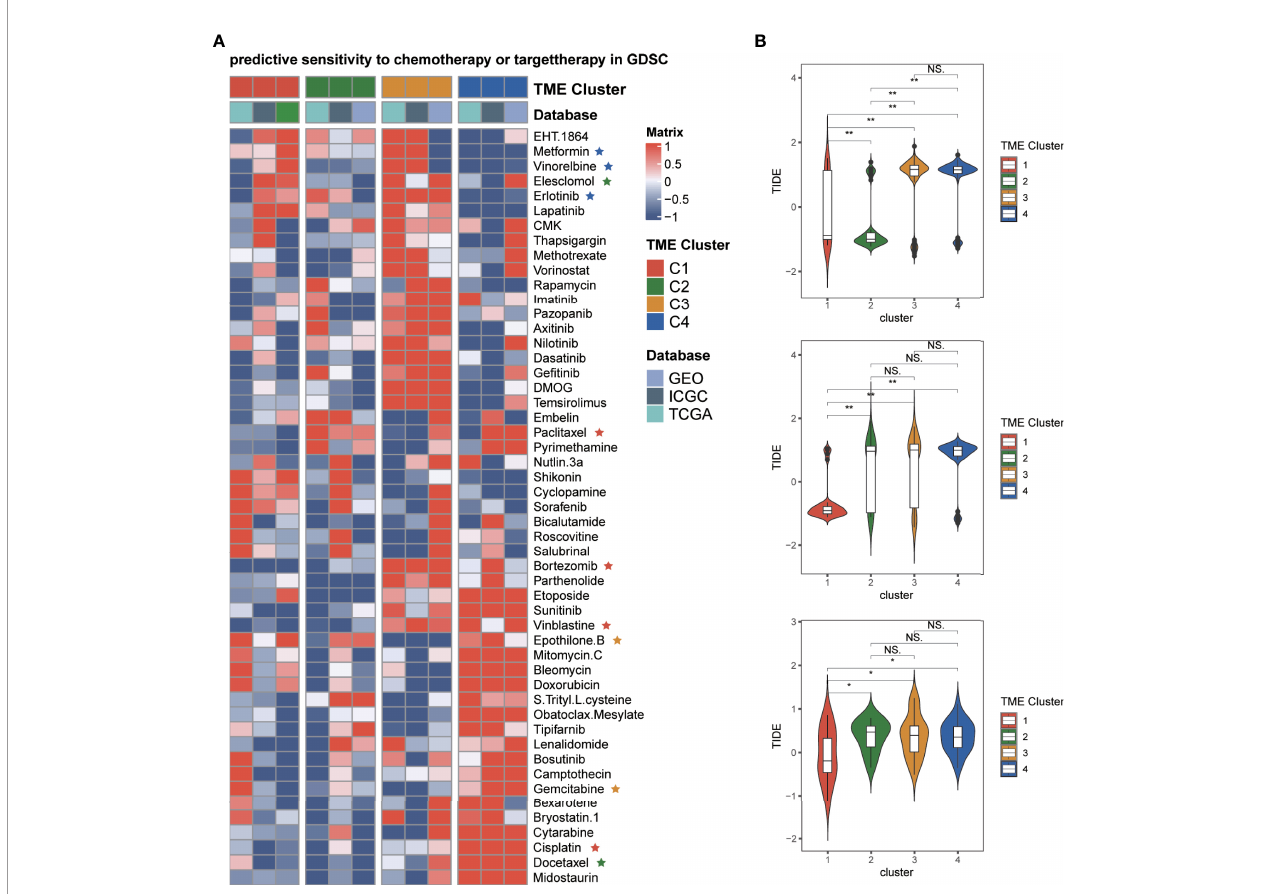
FIGURE 7 | Predicting the ef fi cacy of each TME cluster. (A) Heatmap of drug sensitivity in patients of different TME clusters in TCGA, Japanese, and Hoshida Y et al. cohorts. (B) Violin plots showed the comparison of the TIDE score of TME clusters in TCGA, respectively. *p ≤ 0.05, **p ≤ 0.01, ns: p>